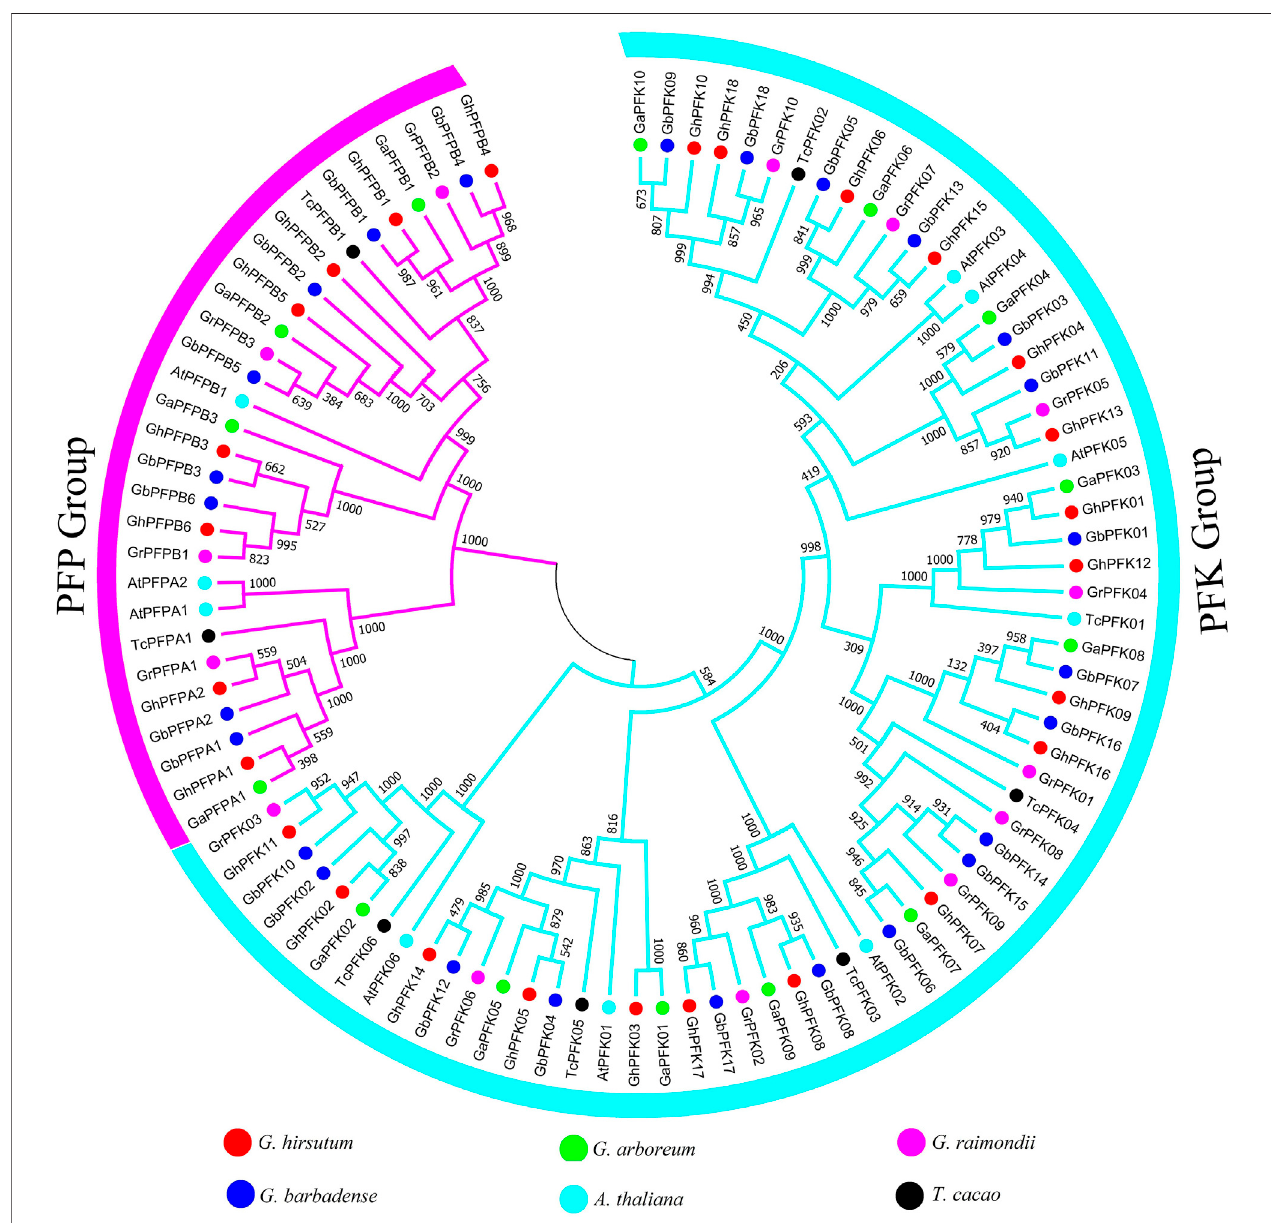
FIGURE 1 | Phylogenetic tree analysis of PFK genes in G. hirsutum , G. barbadense , G. arboreum , G. raimondii , A. thaliana, and T. cacao . The tree analysis categorized the PFK gene family into two big groups of PFK and PFP which are highlighted in blue and violet colors.